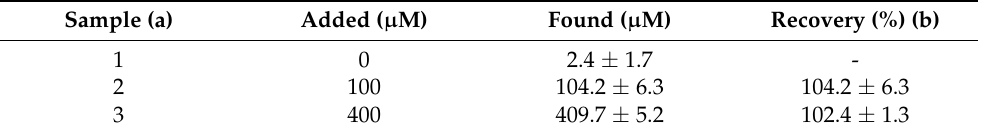
Table 3. Recovery test of the present ECL sensor for NADH in human serum